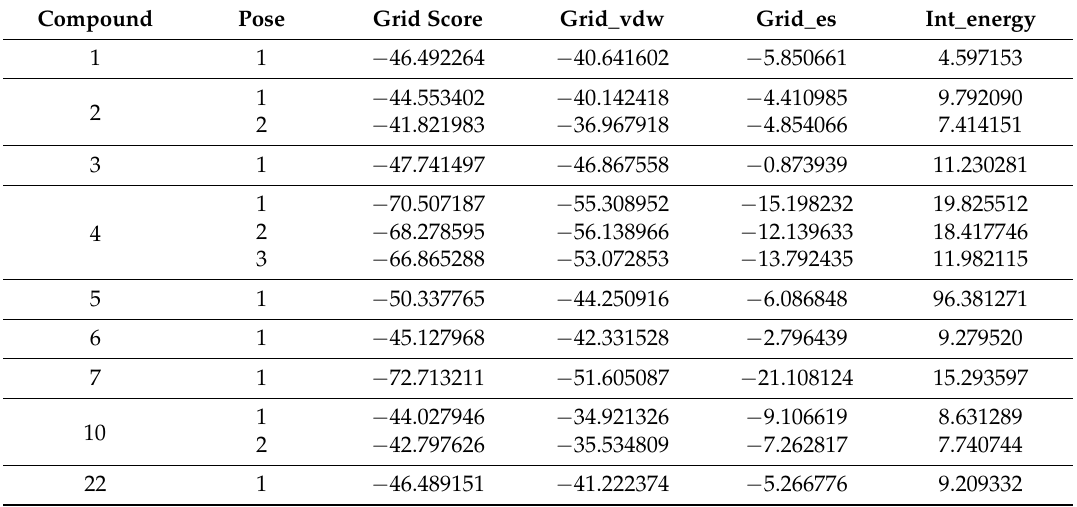
Table 2. Docking of ligand with receptor histone deacetylase (HDAC)2 (unit: kcal/mol).